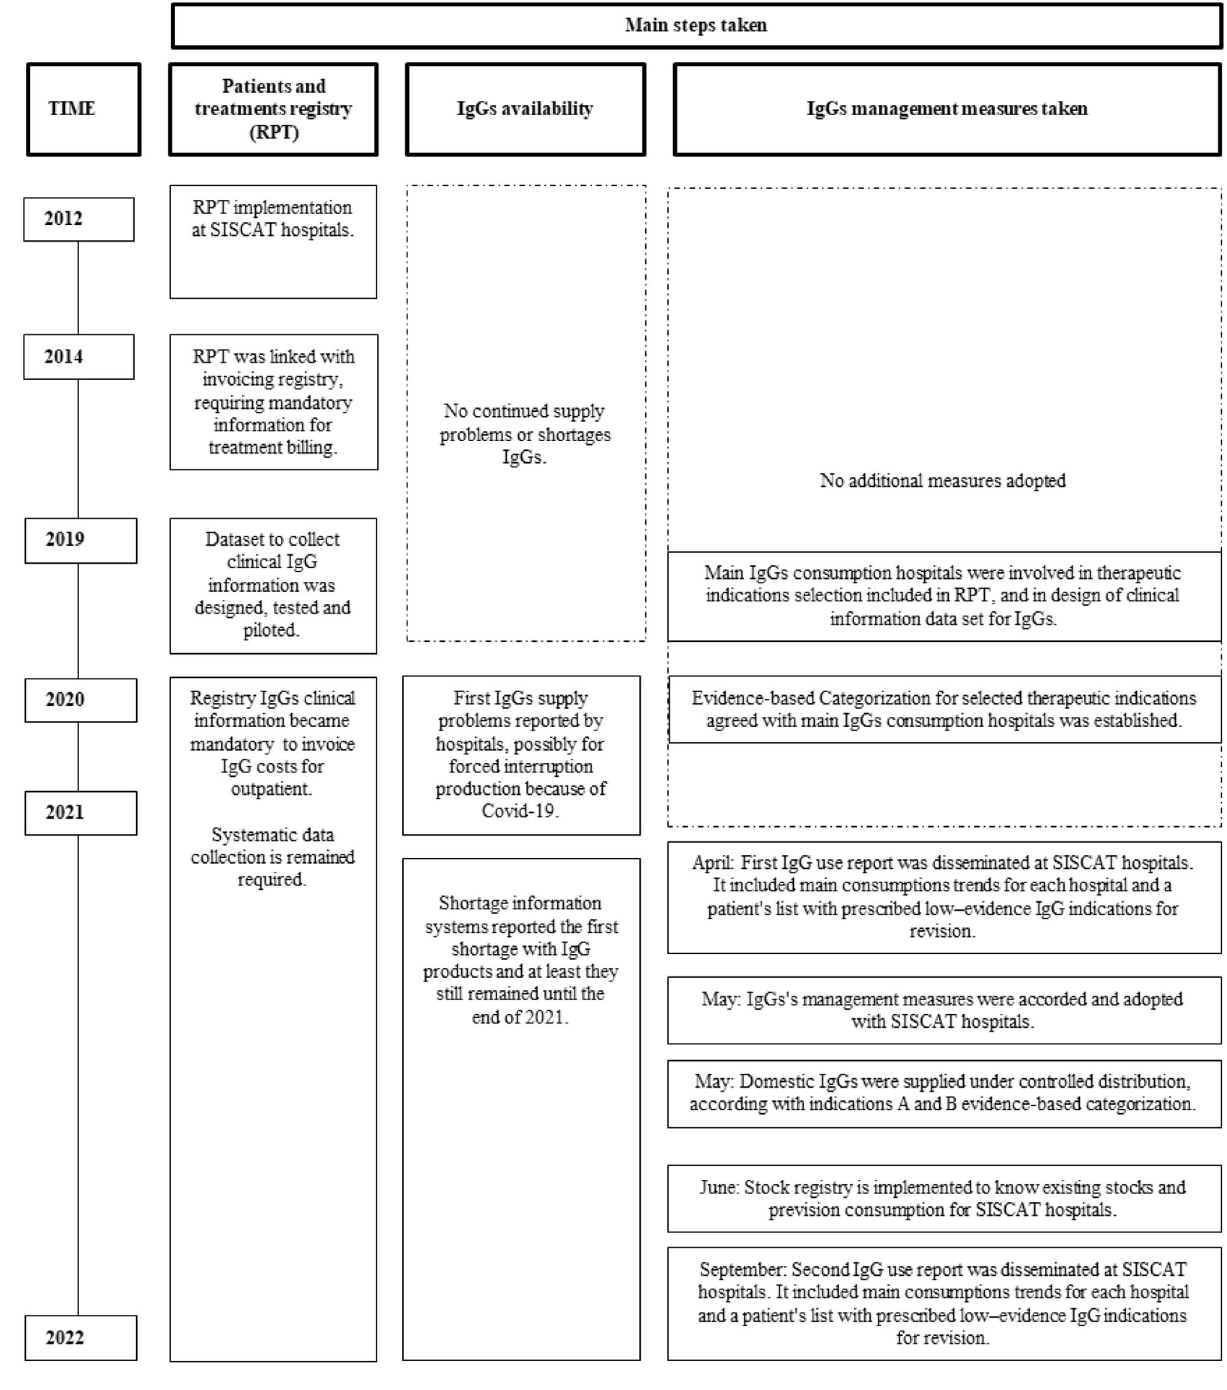
− 3.29 to 7.4%. In the last 4 years, the increase has been positive and has grown by 6.24% on average ( Figure 2